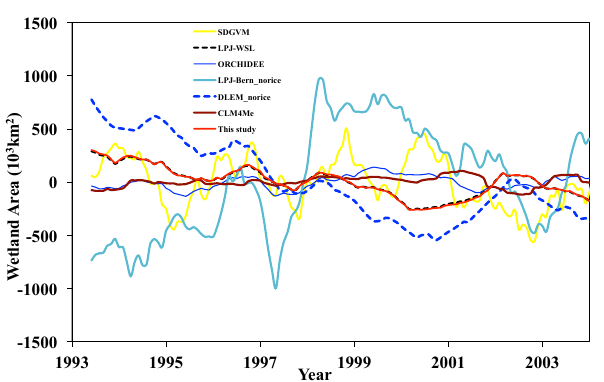
Figure 17. 12-month smoothed average of the anomalies in wet- land areal extent used in the models that participate in WETCHIMP project (Melton et al., 2013; Wania et al., 2013) and in this study (satellite-derived inundated area obtained from Prigent et al. (2007) and Papa et al., 2010). LPJ–Bern_norice and DLEM_norice are LPJ–Bern and DLEM models that do not include rice paddy sim- ulations, respectively. These notifications indicate WETCHIMP project also produce simulations with rice and only no rice sim- ulations are included in this comparison study. In this figure, the long-term mean (1993–2004) is removed from each data set.